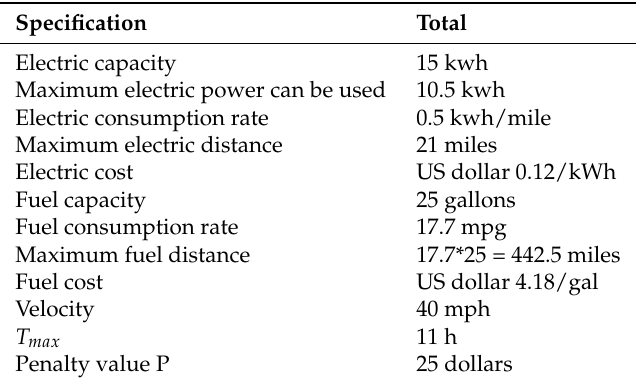
Table 1. Data of Vehicles